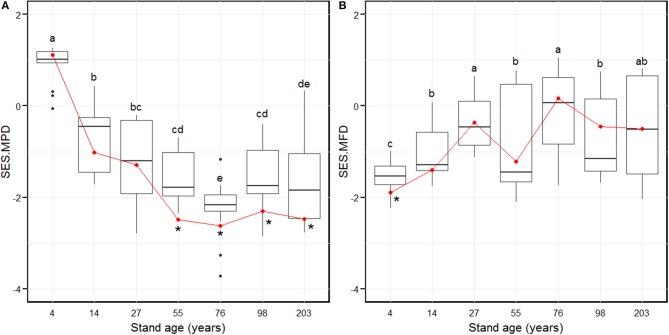
Standardized effect size of phylogenetic diversity (SES.MPD, A) and functional diversity (SES.MFD, B) along with stand age which were measured as the mean pairwise phylogenetic distance and the mean pairwise functional distance of the 88 plots over 203 years of succession, based separately on phylogeny and the functional dendrograms. Stand ages from 4 to 203 years represent early stand initiation, late stand initiation, early stem exclusion, late stem exclusion, early canopy transition, late canopy transition, and gap dynamics stages, respectively. The boxplot midlines correspond to the median value for each stand age; upper and lower hinges represent the first and third quartiles. Letters indicate significant differences of the mean SES values (p < 0.05) across the stand age. Red dots correspond to the SES values at a larger spatial scale by summing the plot composition for each stand age, and asterisks indicate a significant difference from the null model.